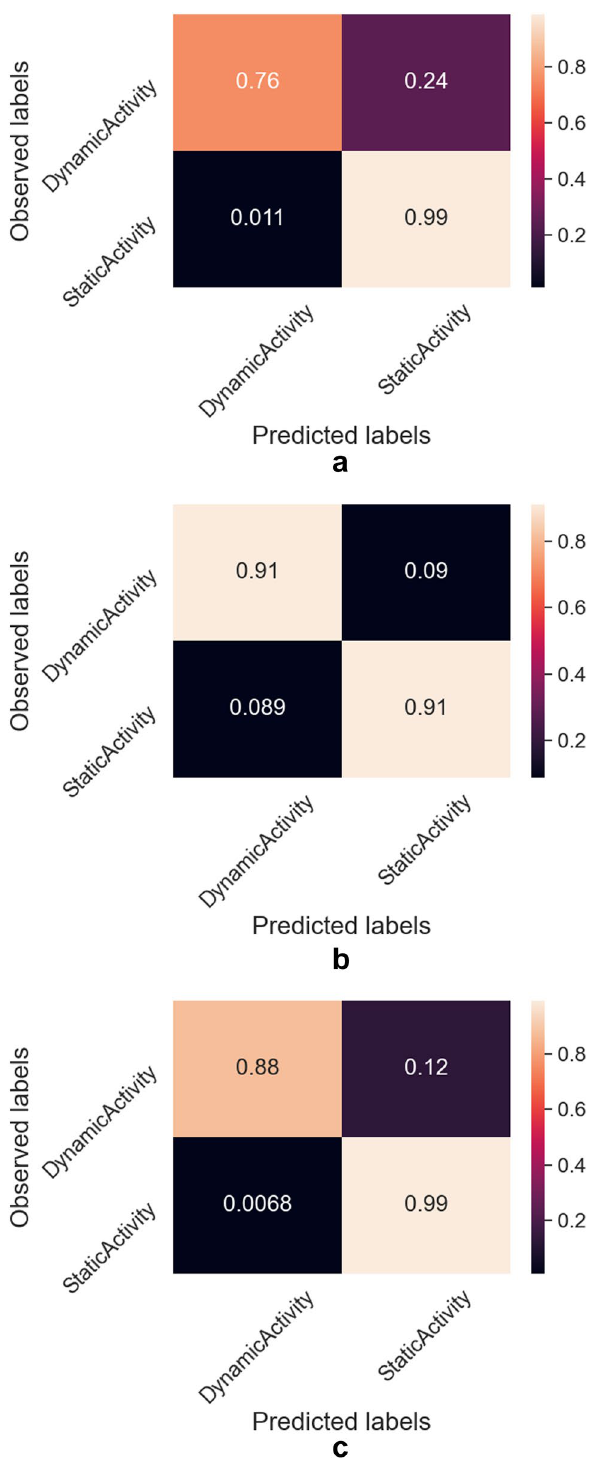
Figure 4. Confusion matrices of examined activity recognition binary models. ( a ) Decision Tree. ( b ) Gradient Boosted Trees. ( c ) Random